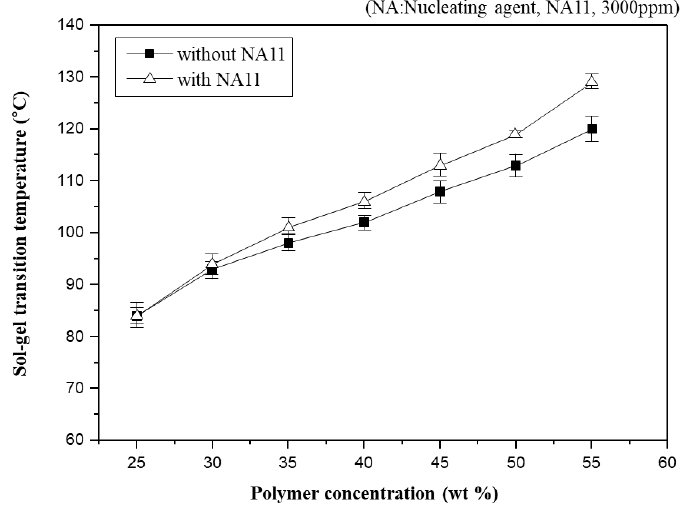
Figure 4. Sol-gel transition temperature changes (T sg ) as a function of polymer concentration for the PVDF/GBL system.